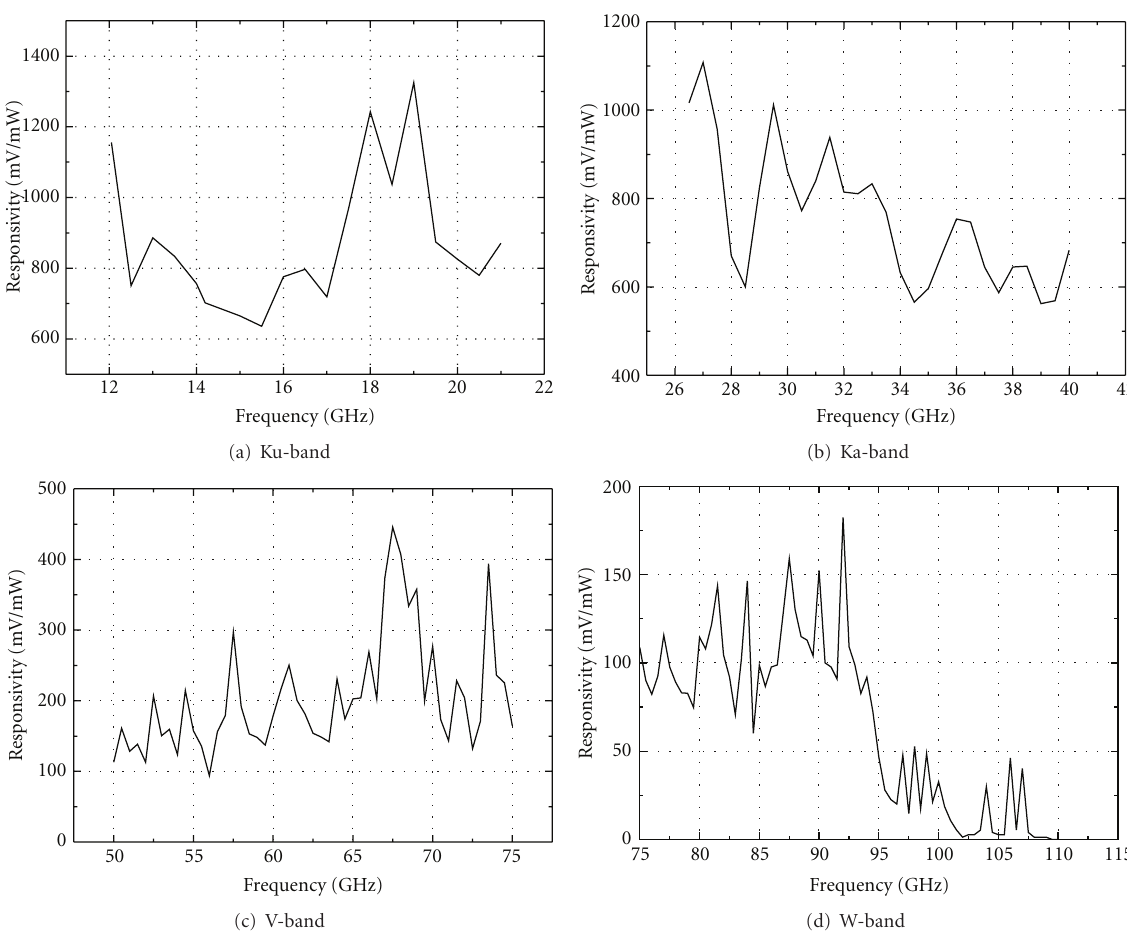
Figure 16: Frequency responses test results of the THz wave planar integrated active microstrip antenna covered by a dielectric